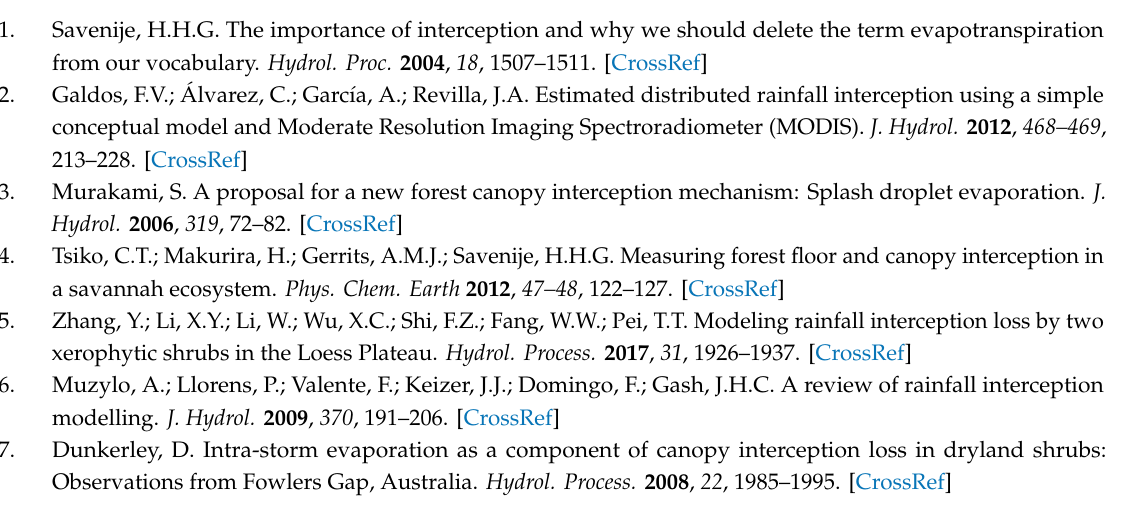
Figure S1: Spatial patterns of annual rainfall from 2004 to 2016 in Guangdong, Figure S2: Spatial patterns of annual rainfall from 2004 to 2016 in seven major basins in Guangdong, Figure S3: Spatial patterns of annual mean LAI from 2004 to 2016 in Guangdong, Figure S4: Spatial patterns of annual mean LAI from 2004 to 2016 in seven major basins in Guangdong, Figure S5: Spatial patterns of annual mean canopy rainfall interception rate (CRIR) from 2004 to 2016 in Guangdong, Figure S6: Spatial patterns of annual mean CRIR from 2004 to 2016 in seven major river basins in